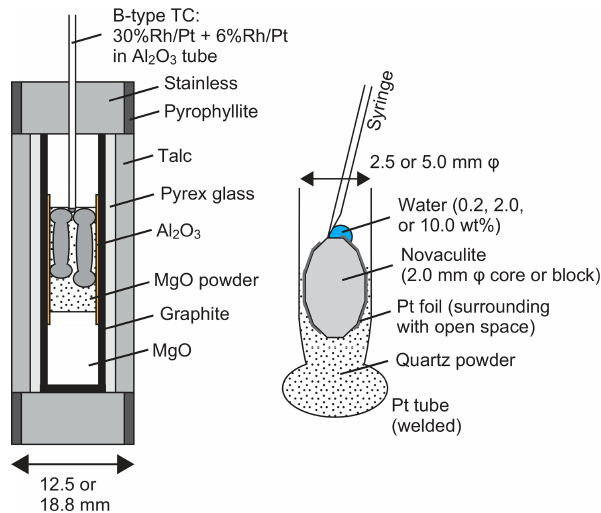
Figure 3. Sample assembly (left) and preparation of the novaculite, quartz powder, and water in a Pt tube